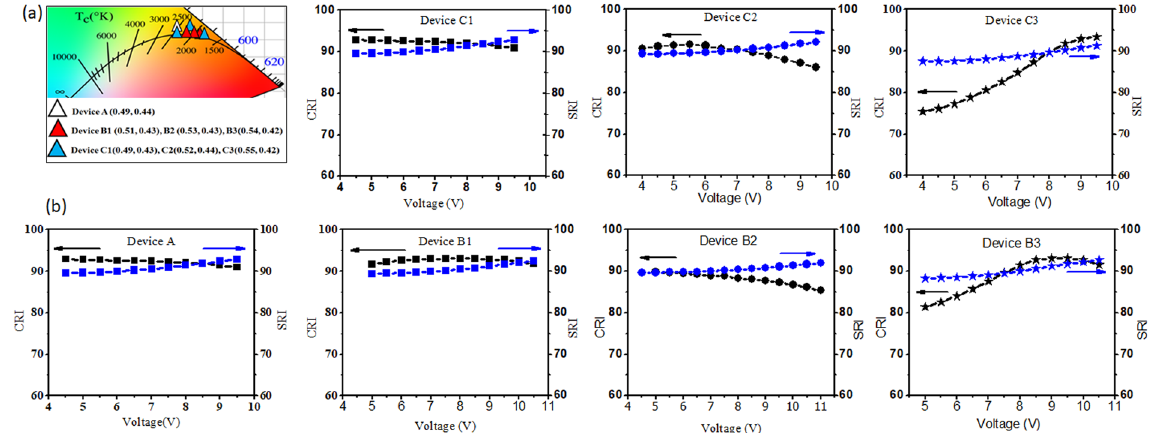
Figure 4. ( a ) Chromaticity coordinates on 1931 CIE diagram and ( b ) color rendering indices versus applied voltage characteristics of the studied wet-processed OLEDs.